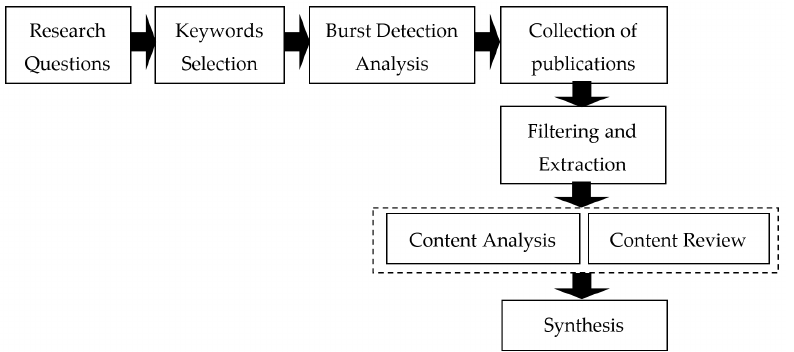
Figure 3. Research design and procedure.